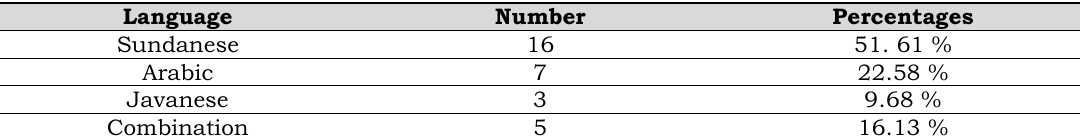
Table 2. the percentage of parents’ name based on its language origin